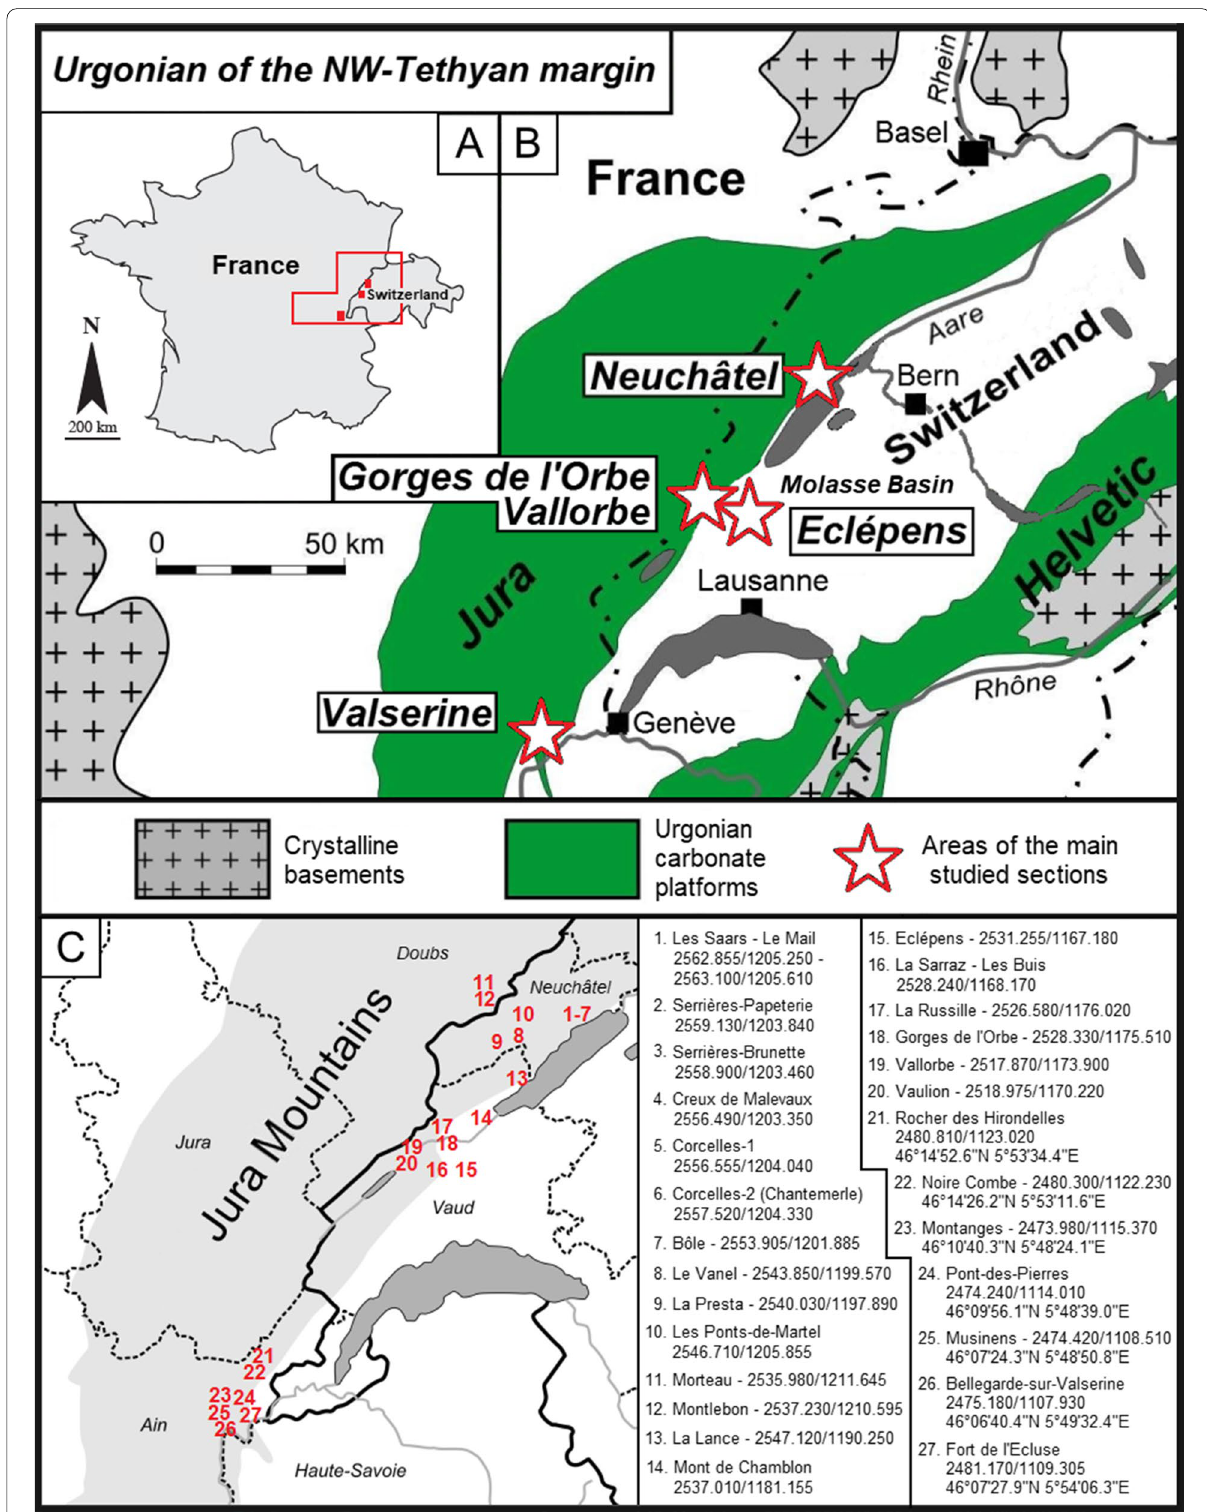
Fig. 1 General map ( A ) with the red frameworks of map B and the 3 groups of studied sections, detailed map ( B ) with location of the studied sections indicated ( C ) by numbers in red and coordinates after the map of Switzerland (Swiss Federal Coordinates LV95) and IGN map of France (DMS coordinates); see also Fig. 10 for the detailed Neuchâtel area (sections